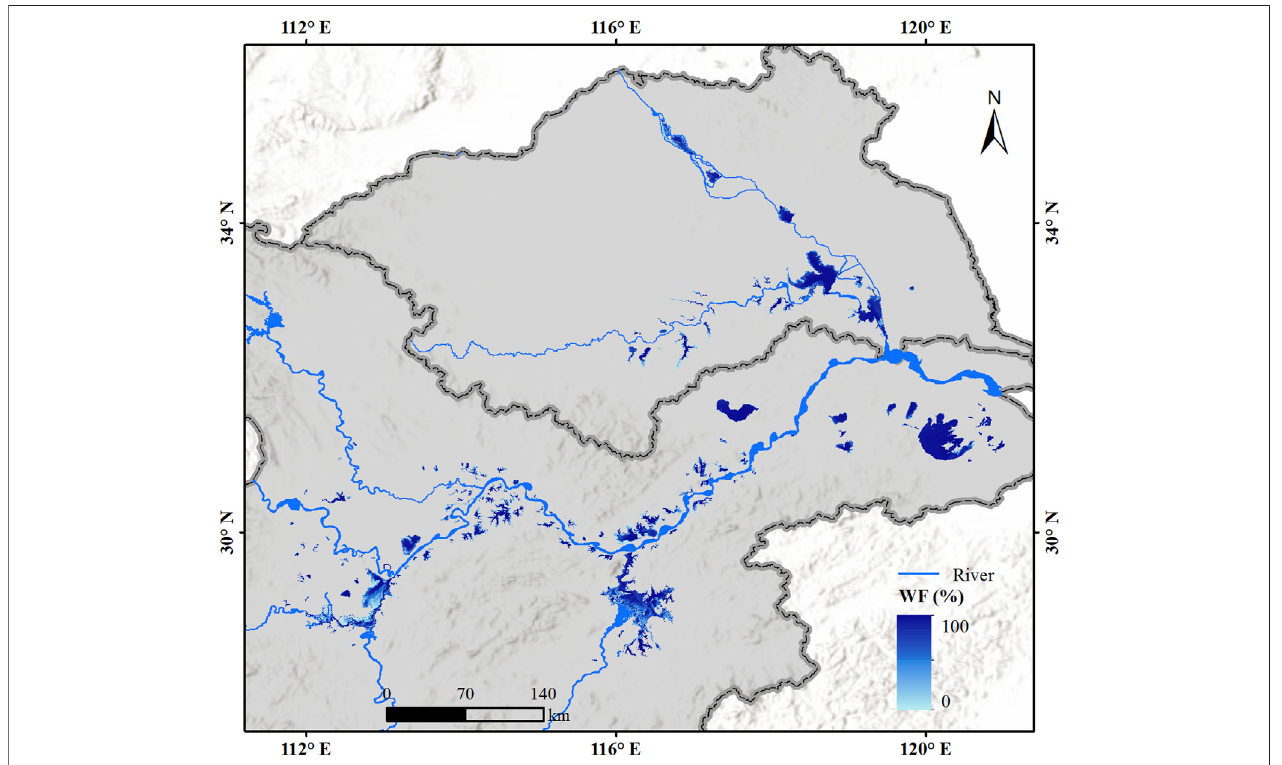
FIGURE 7 | Map of WF for the plain lake group (area > 10 km 2 ) in the YHRB.